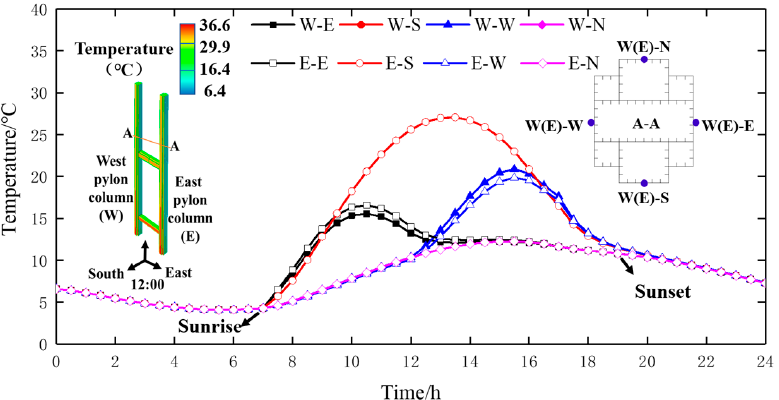
Figure 14. Temperature variation curve of cross-section A-A on bridge pylon in winter.